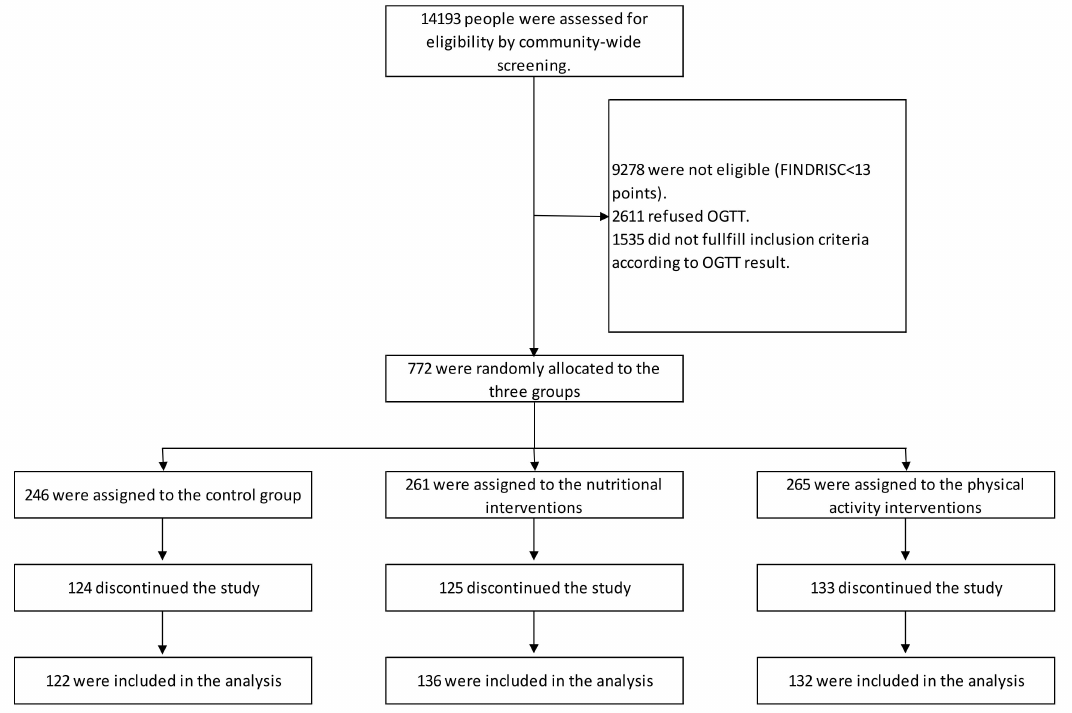
Figure 1. Eligibility, random allocation, and follow-up of the study participants. Discontinued intervention refers to participants who discontinued, due to being lost in the